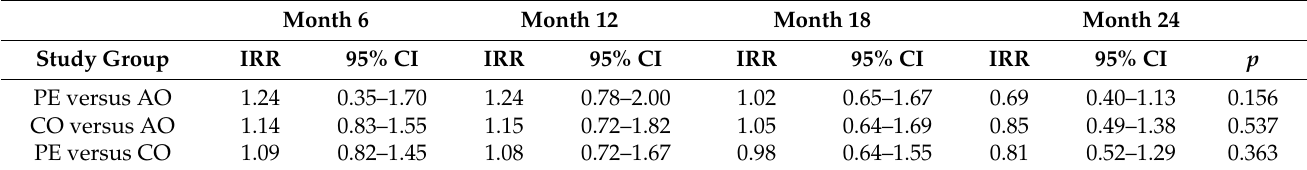
Table 3. Incidence rate ratios (IRRs) of persons who smoke compared to persons who do not smoke with regard to study group net changes in alcohol use over 24 months.